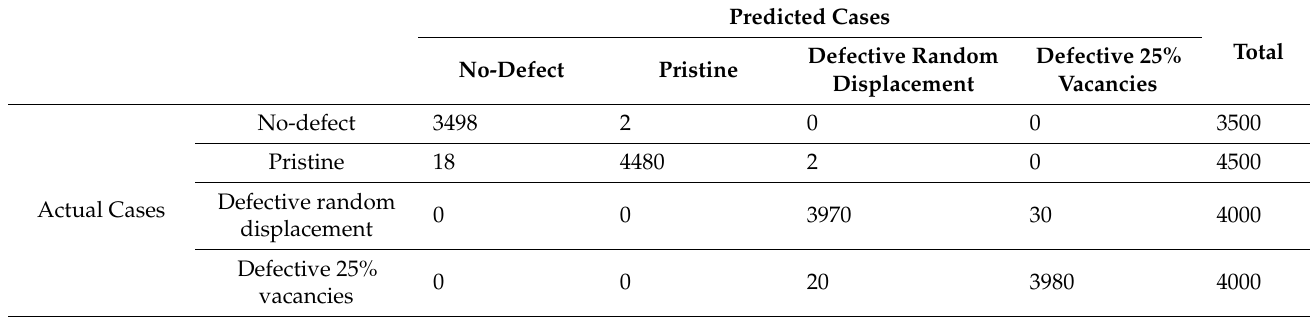
Table 6. Experimental Results for Exper ‐ 2.